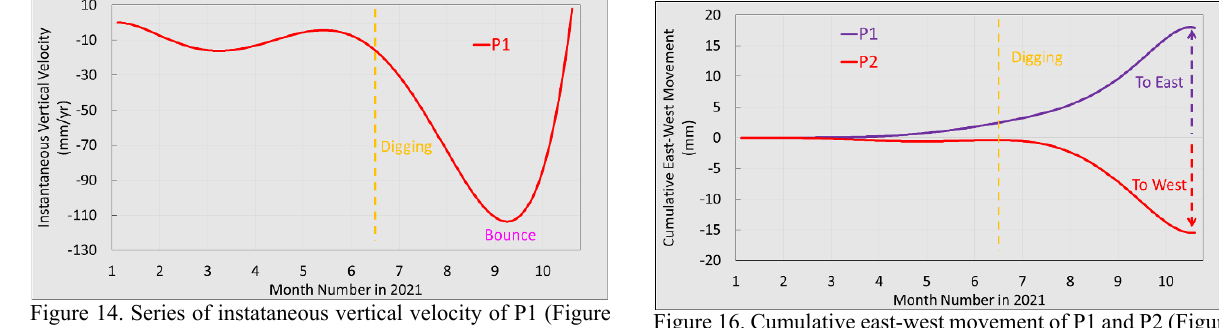
Figure 16. Cumulative east-west movement of P1 and P2 (Figure 15). Mining occurred in middle June.